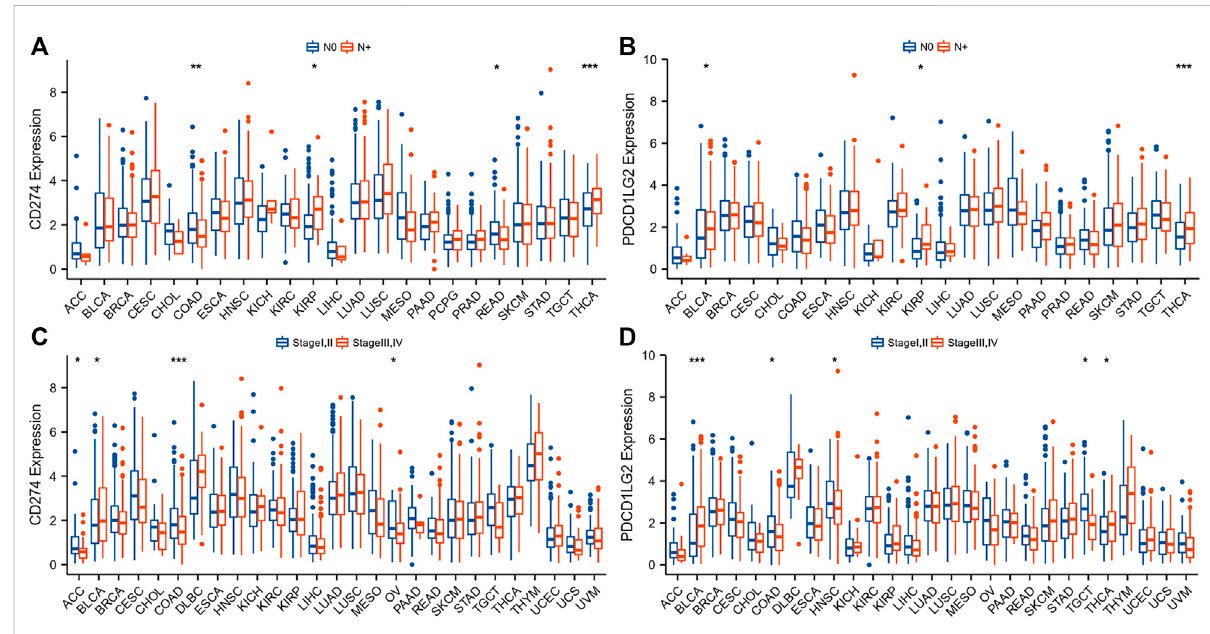
FIGURE 2 Association between CD274/PDCD1LG2 levels and clinical characteristics. (A,B) N stage. (C,D) Clinical stage. ( “ N+ “ : primary tumor with lymph node metastasis; * p < 0.05, ** p < 0.01, *** p <